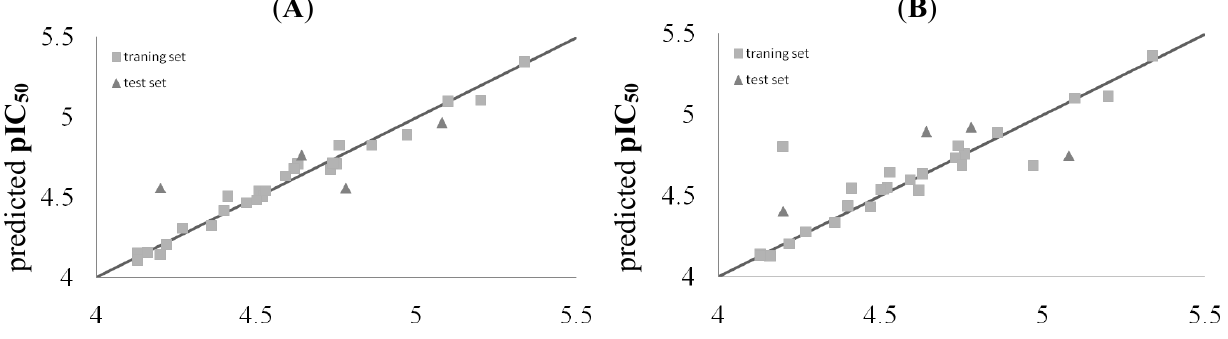
Figure 2. ( A ) The experimental and Predicted activities of CoMFA; ( B ) The experimental and Predicted activities of